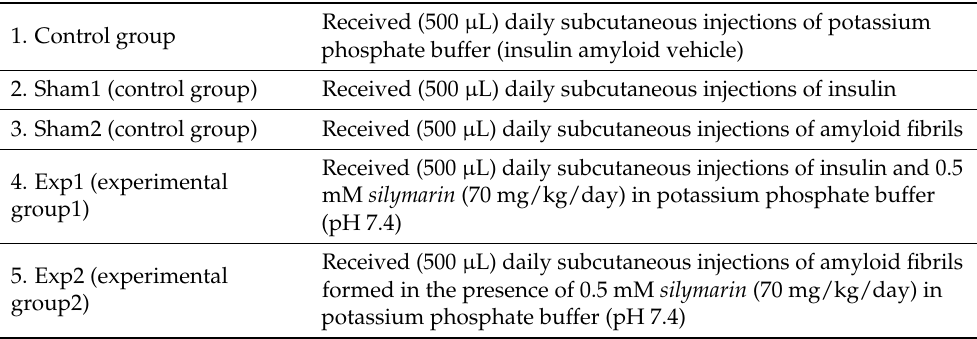
Table 1. Experimental design: description of the animal groups used in the